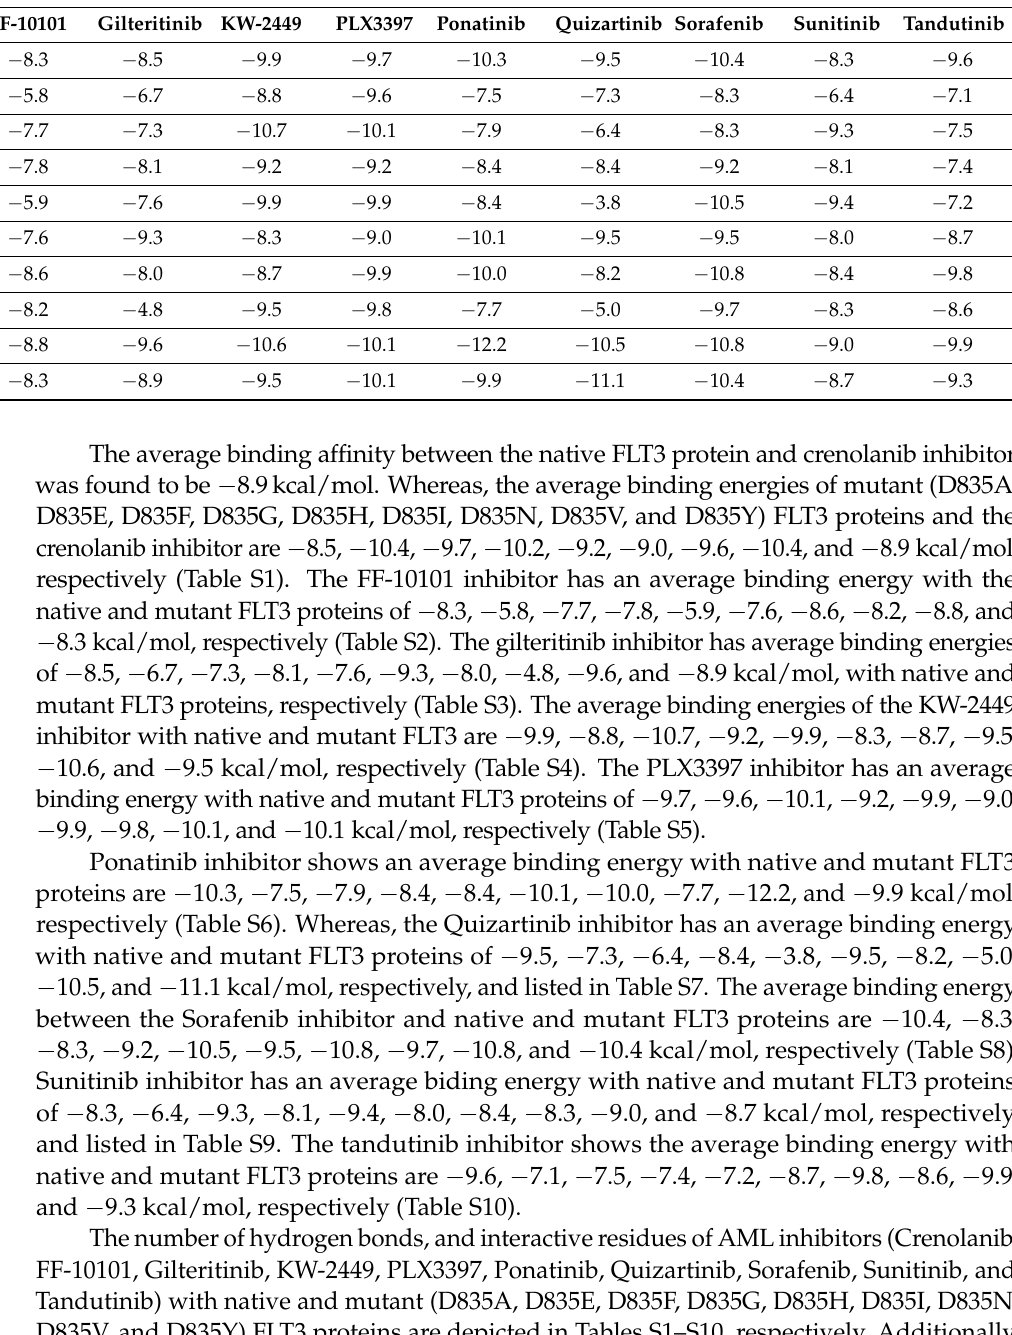
Table 3. Binding energy of native and mutant FLT3 proteins (200 ns) with inhibitors. Protein Type (0 ns)